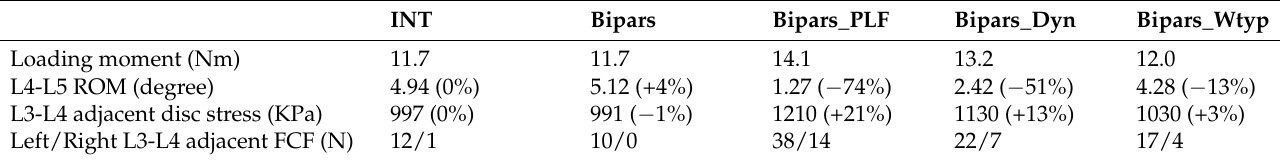
Table 4. ROMs, adjacent disc stress, and adjacent FCF in lateral bending.